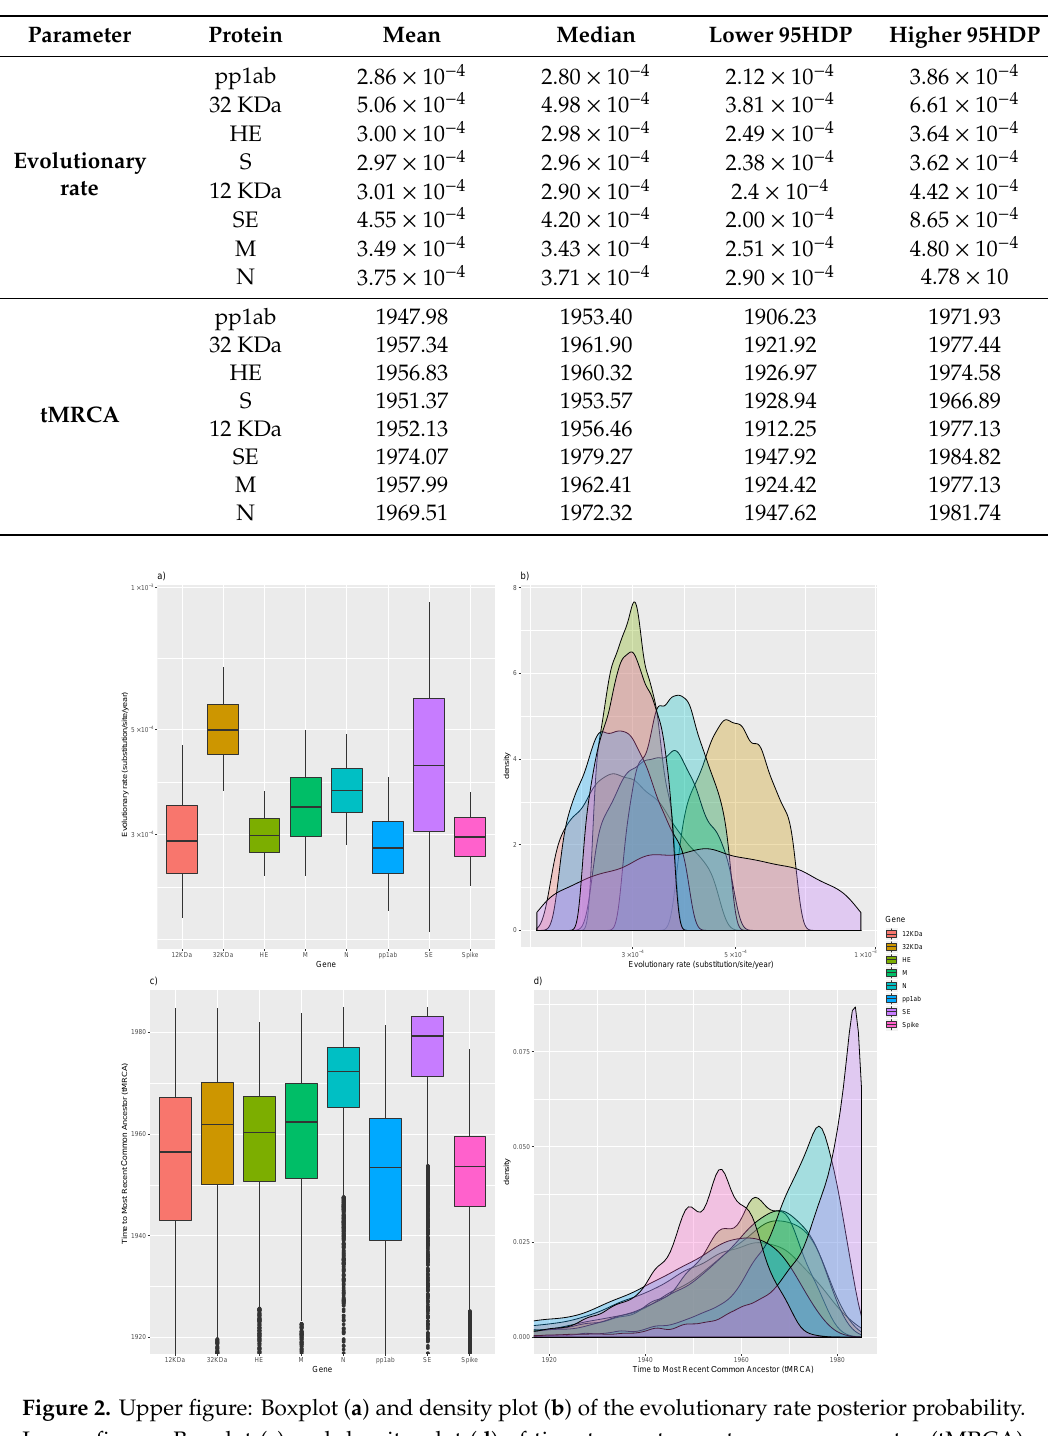
Table 1. Estimation of evolutionary rate and time to most recent common ancestor (tMRCA) for di ff erent protein-coding genes. Mean, median, and 95% high posterior probability (95HPD) summary statistics are reported.